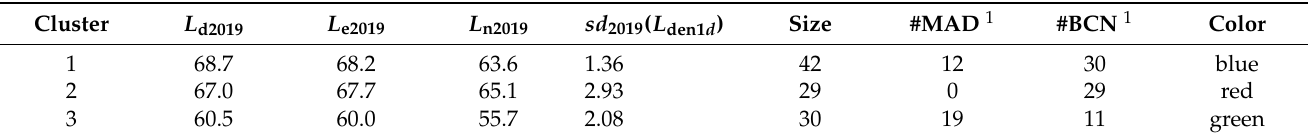
Table 6. Size and centroid of clusters using data collected during 2019 for k = 3 Hierarchical Agglomeration